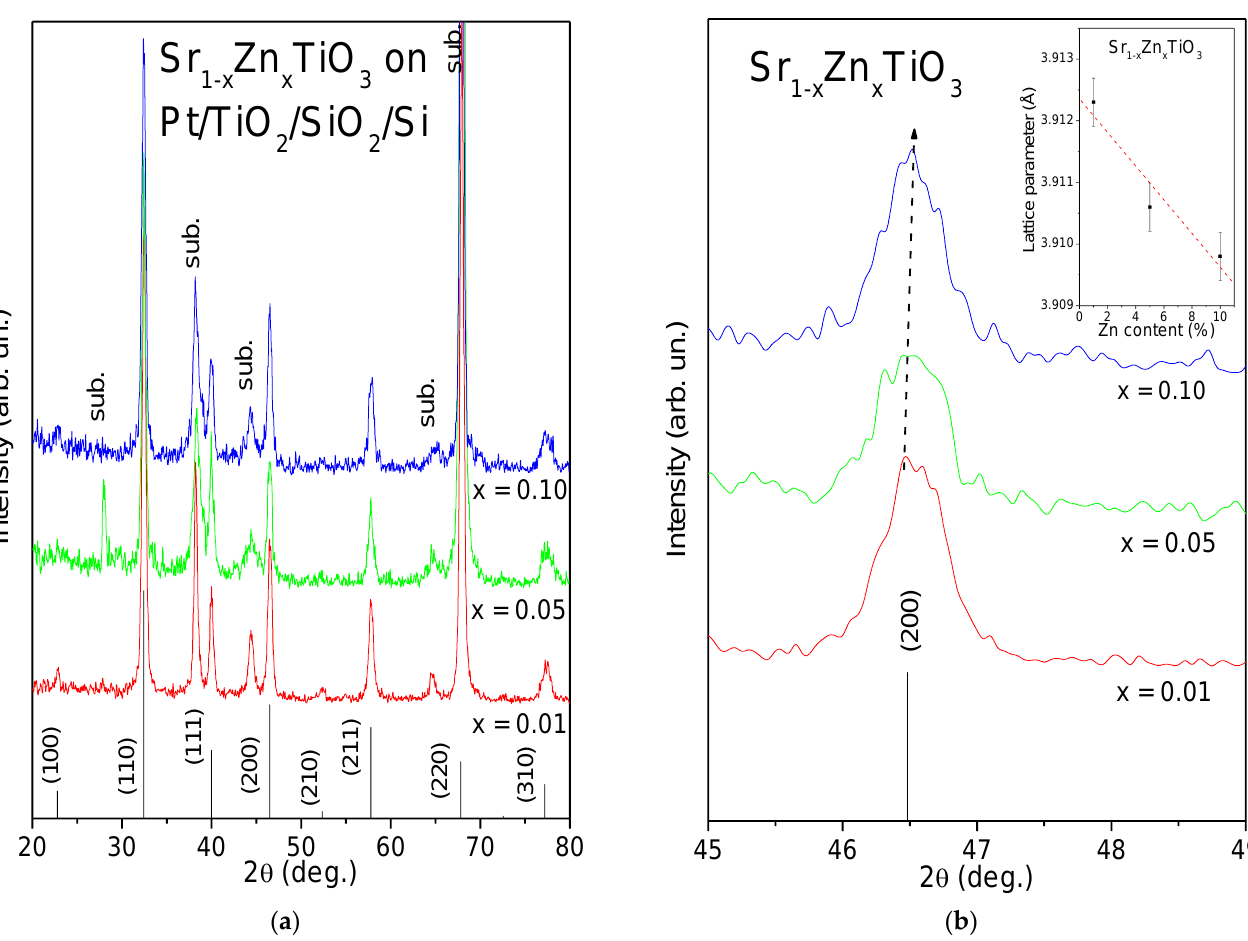
Figure 1. XRD profiles ( a ) and magnified view at (200) reflections ( b ) for Sr 1-x Zn x TiO 3 thin films with x = 0.01, 0.05, and 0.10 deposited on Pt/TiO 2 /SiO 2 /Si substrates as well as reflections related to perovskite structure of SrTiO 3 card PDF#35-0734 marked by corresponding indexes. Inset in ( b ) shows the lattice parameter variation with Zn content.